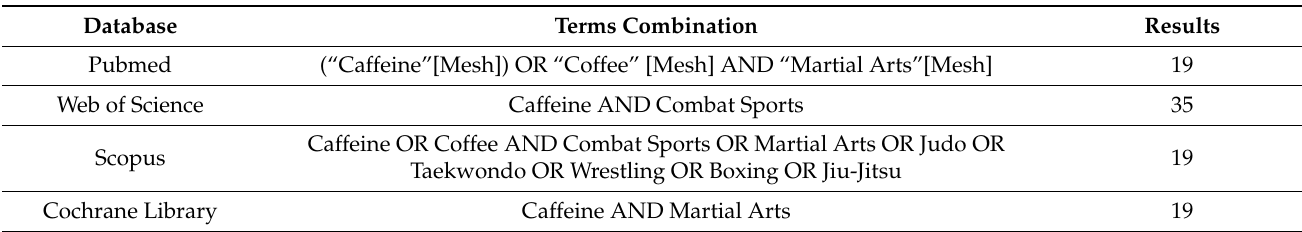
Table 1. Terms combinations and search results on each